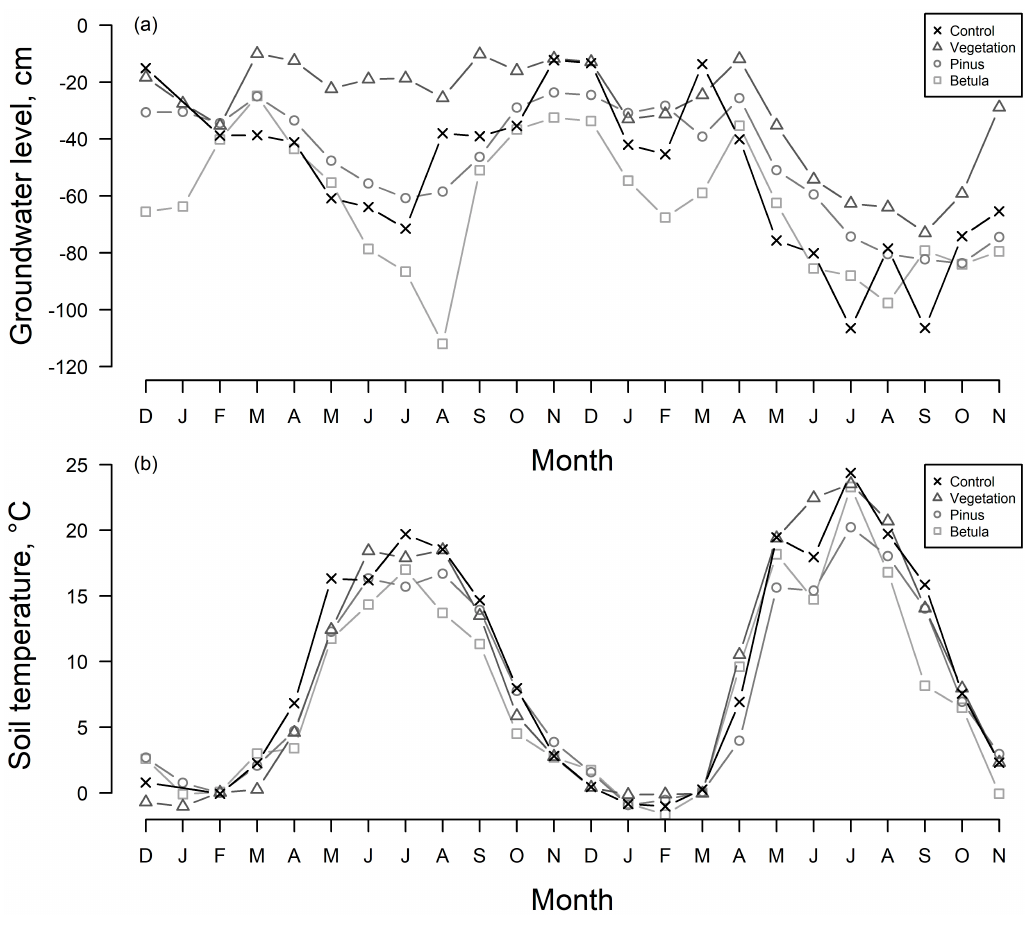
Figure 1. The average groundwater level ( a ) and soil temperature at 5 cm depth ( b ) per measurement month in each field starting from December 2016. Table 2. Soil characteristics of study objects at all sampling depths (0–150 cm).